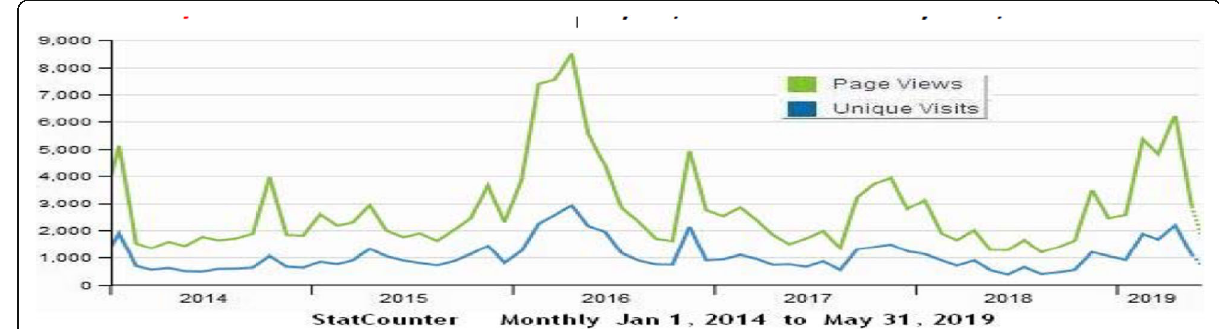
Fig. 19 Monthly visits to VarSITI web site: green — total visits; blue — unique